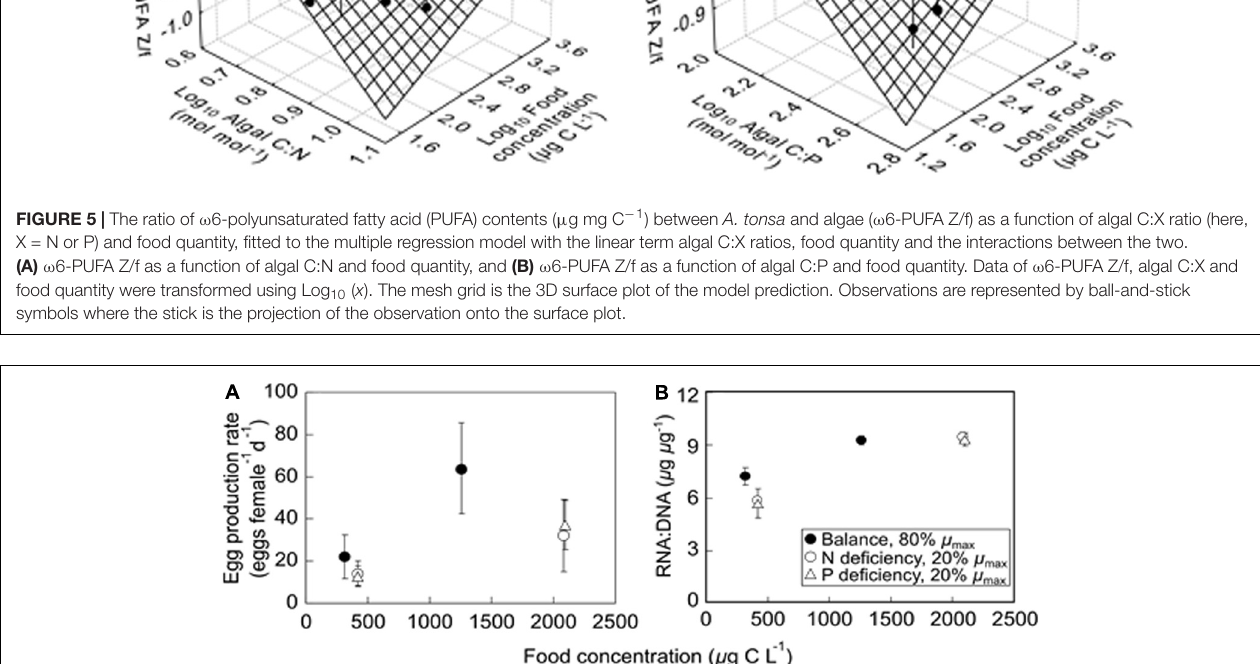
FIGURE 6 | Egg production rate (A) and RNA:DNA (B) (mean ± SD) in A. tonsa feeding on Rhodomonas sp. under different food quantity and quality treatments [N- and P-deficient and slow growing diets (20% of µ max ) and the balanced nutrient and fast growing diet (80% of µ max